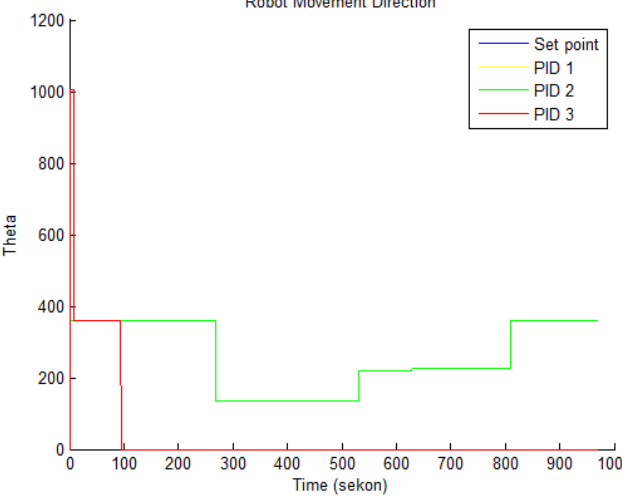
Figure 18. Robot Movement Direction of Three PID Scenarios.